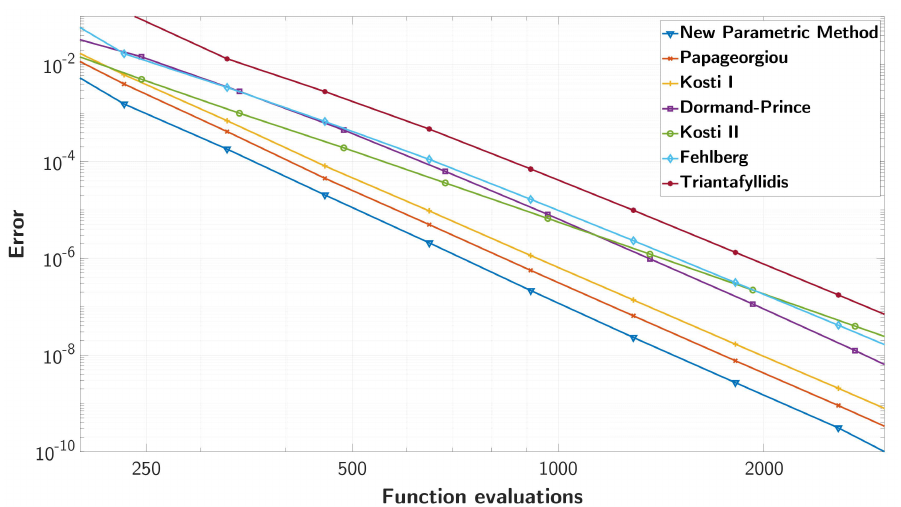
Figure 16. The maximum absolute error of the solution versus the function evaluations, for all compared methods.